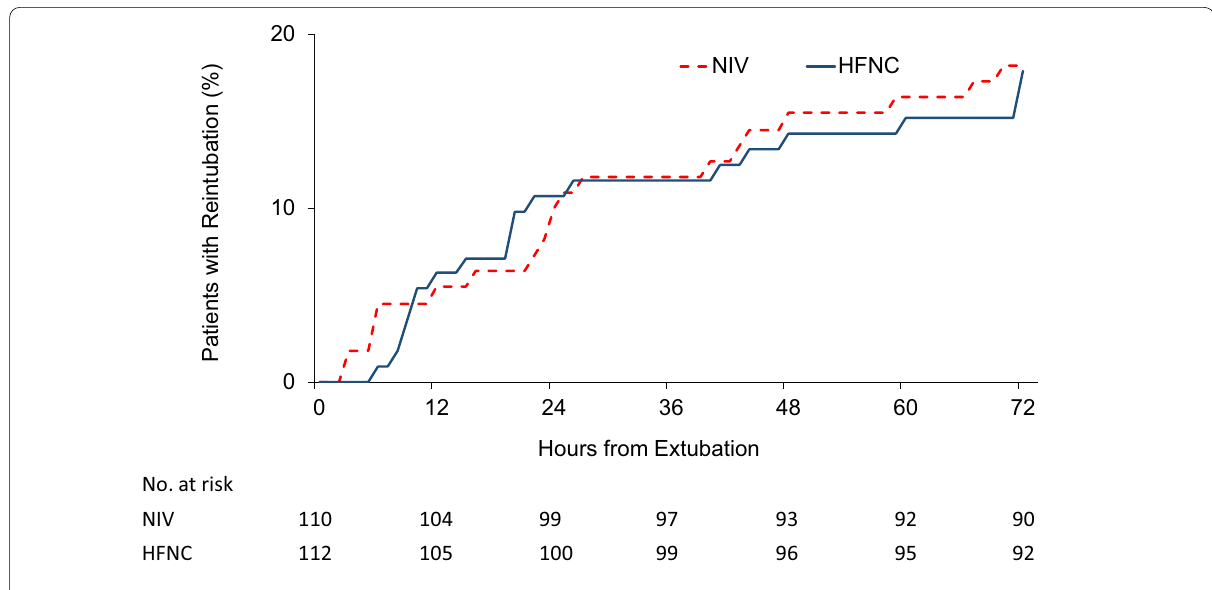
Fig. 2 Kaplan–Meier analysis of time from extubation to reintubation. The cumulative reintubation probability was no different between HFNC group and the NIV group (log-rank P 0.95). HFNC: High-flow nasal oxygen cannula; NIV: Noninvasive mechanical =